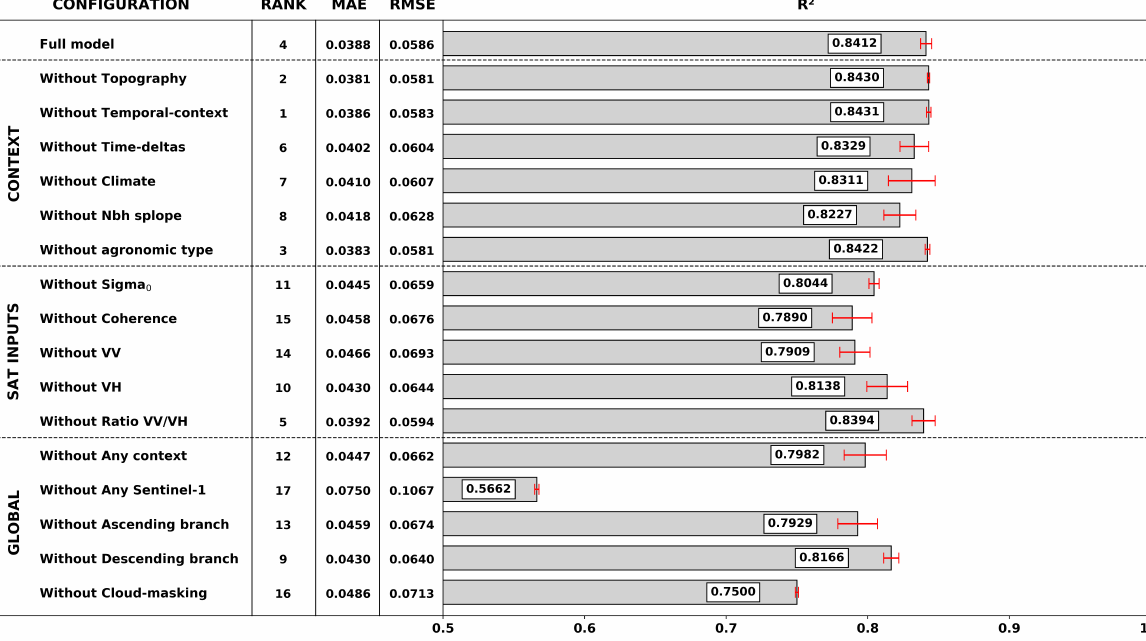
Figure 3. Ablation study of the SenDVI Sentinel-1 to Sentinel-2 NDVI regression task. Mean MSE, RMSE and R 2 as well as standard deviation of R 2 ( red bar ) for five runs of each configuration are provided. Ranks are given in terms of R 2